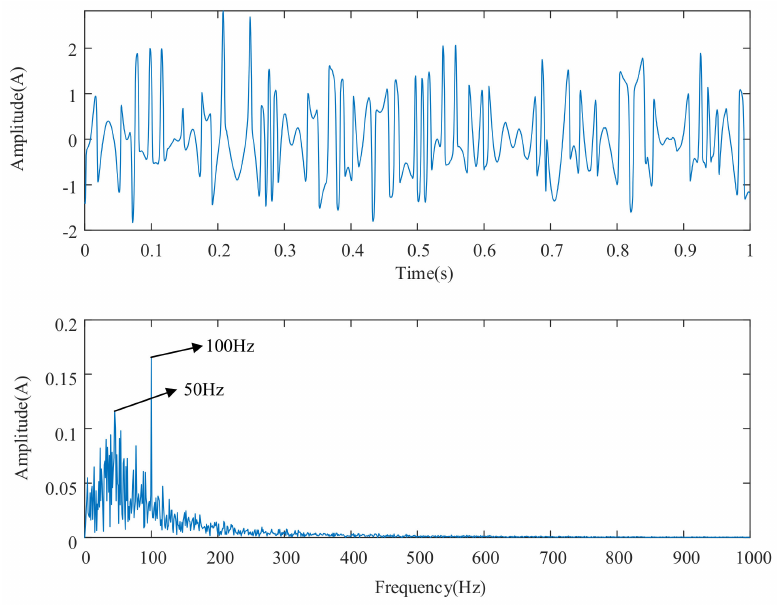
Figure 13. Time − frequency domain waveform of reconstructed signal enhanced by third